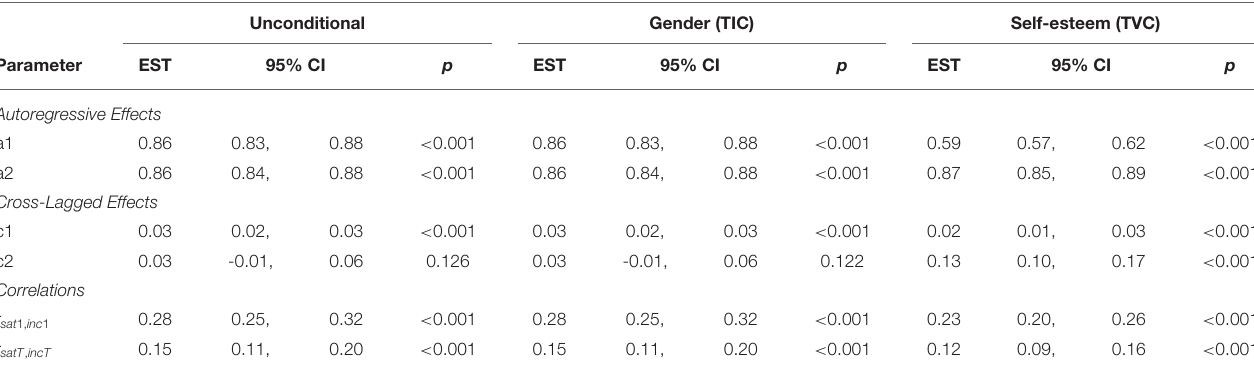
TABLE 2 | Comparison of CLPM models.